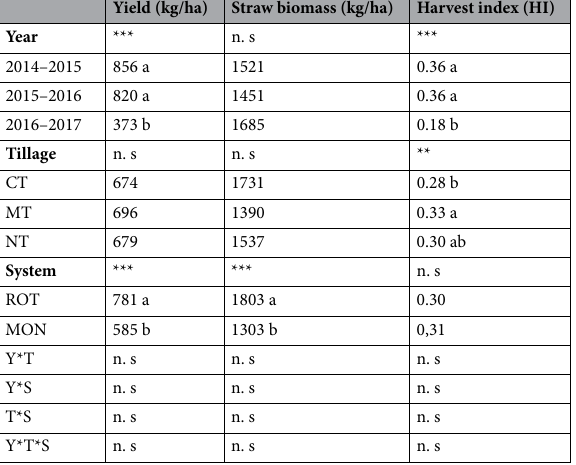
Table 2. Analysis of variance results for years, tillage system, and crop system. Mean values for yield, straw biomass and Harvest Index (HI). Different letters in each column indicate a difference between treatments according to HSD Tukey’s Test with 95% probability level ( p < 0.05); *** = 0.05; ** = 0.1; * = 0.5 CT conventional tillage, MT minimum tillage, NT no tillage, ROT rotation, MON monoculture, Y year, T tillage, S